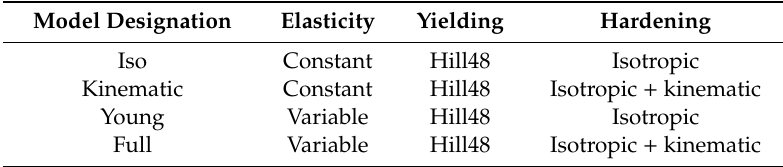
Table 9. Summary of the analysed